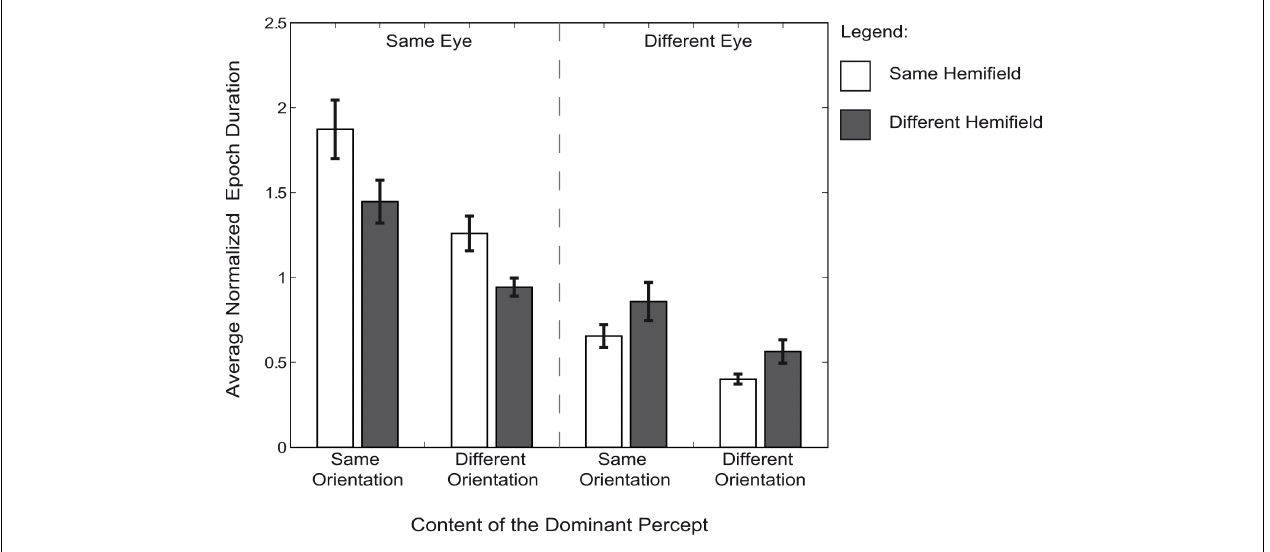
bar represents the dominance duration that two targets were dominant at the same time.The durations of grouping two targets are separated by the targets’ eye-of-origin, the hemifield in which they were presented and their orientation.